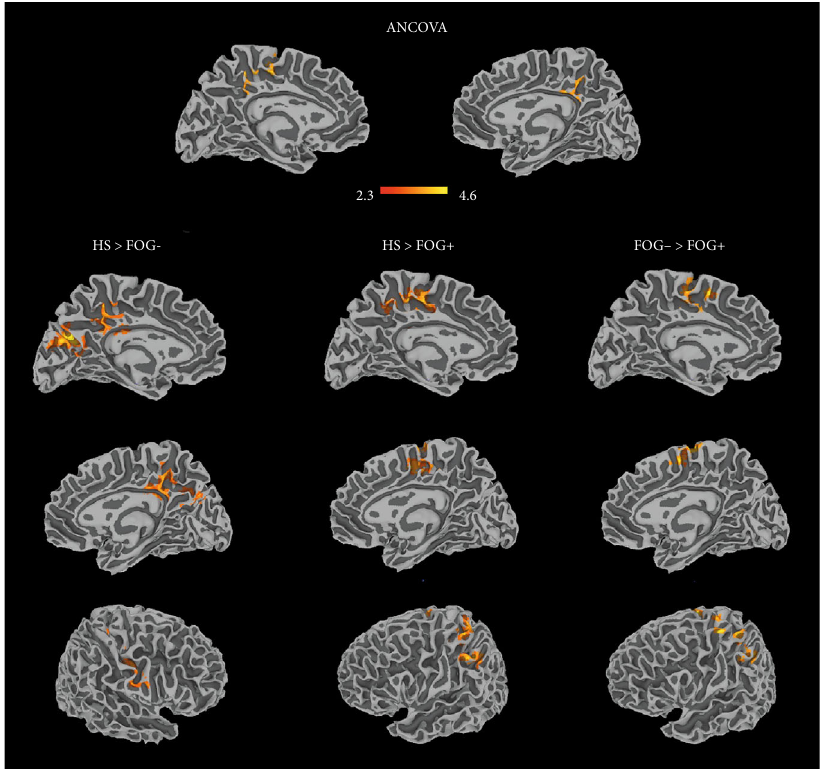
Figure 3: Results of the ANOVA analysis (top) and comparison between subgroups. The results are cluster corrected for multiple comparisons ( Z ≥ 2 : 3 , p < 0 : 05 ) and are shown in MNI